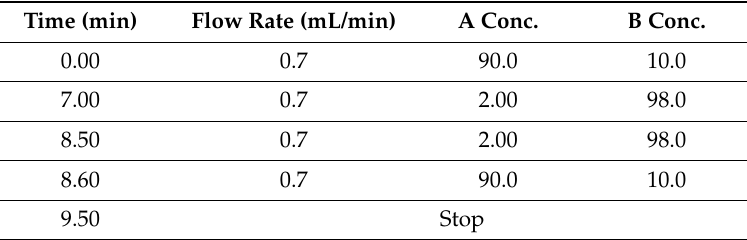
Table 5. LC gradient